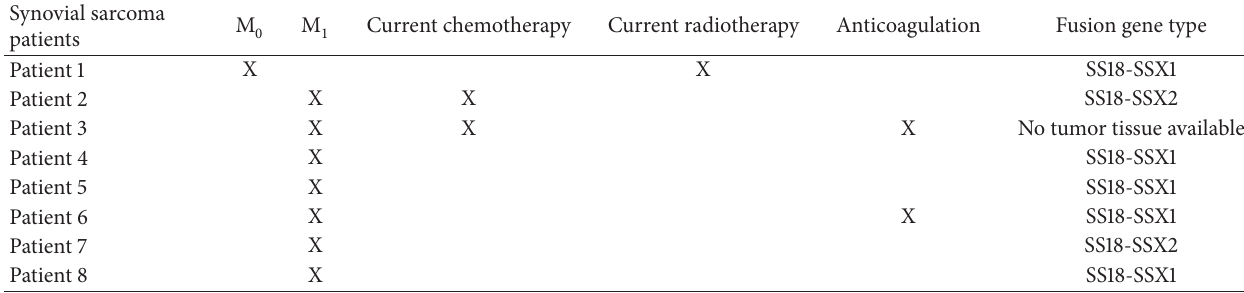
Table 3: Disease and therapy status of patients with synovial sarcoma. M 0 : local disease, M 1 : metastatic disease. Current chemother- apy/radiotherapy/anticoagulation involves treatment within the last 6 weeks.